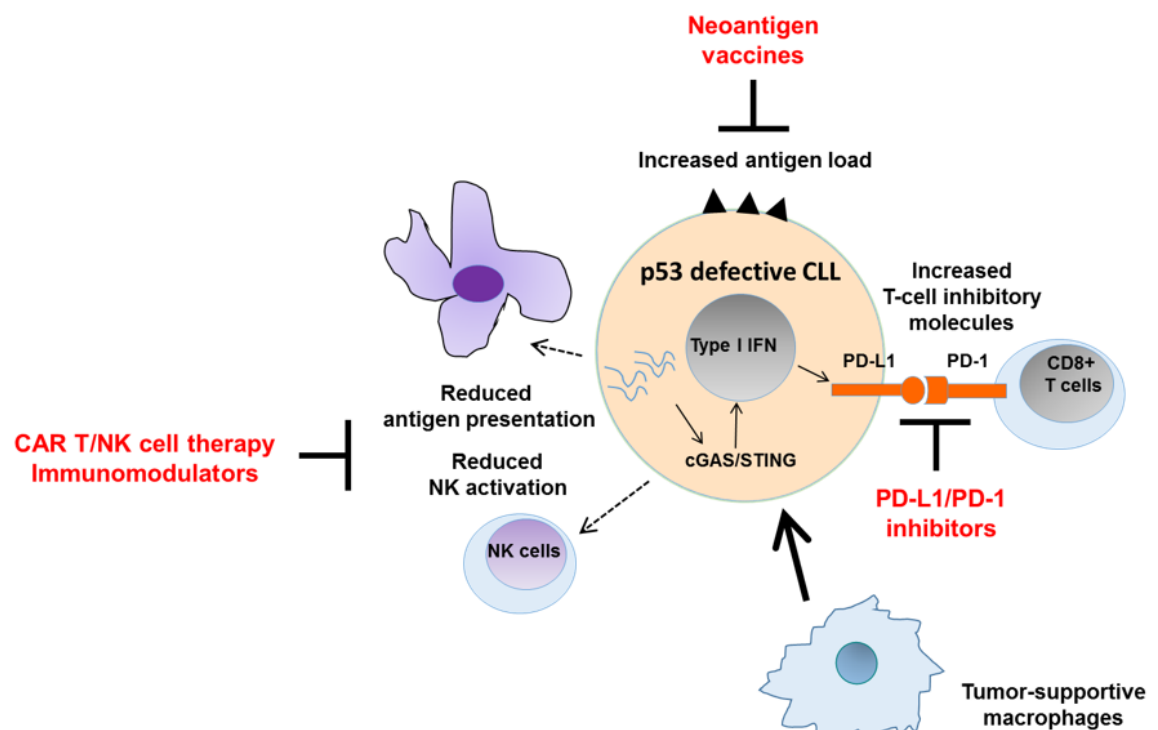
Figure 4. Targeting immune defects associated with a defective p53 pathway. p53 plays an important role in the regulation of antitumor immunity. p53 defective tumors evade immune response through multiple mechanisms, including impaired antigen presentation and T/NK cell activation, as well as macrophage reprogramming towards tumor-supporting phenotypes. In addition, the accumulation of unrepaired DNA damage with subsequent activation of cGAS/STING and type I interferon response could lead to upregulation of the T-cell inhibitory molecule PD-L1. These aspects of immune evasion can be counteracted by the use of various immunomodulatory agents. Defects in the p53 pathway are also associated with enhanced generation of neoantigens. This provides an opportunity for the generation of neoantigen vaccines as a strategy to eradicate p53-mutant tumor cells.